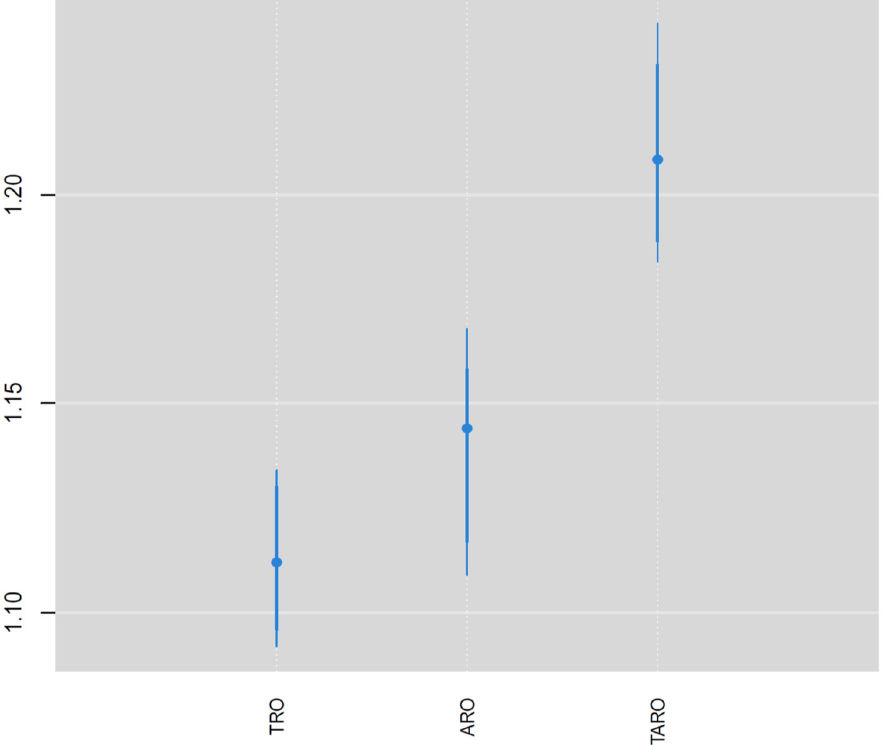
Figure 3. Posterior medians and 95% credible intervals for neighborhood disadvantage index effects by outlet type.